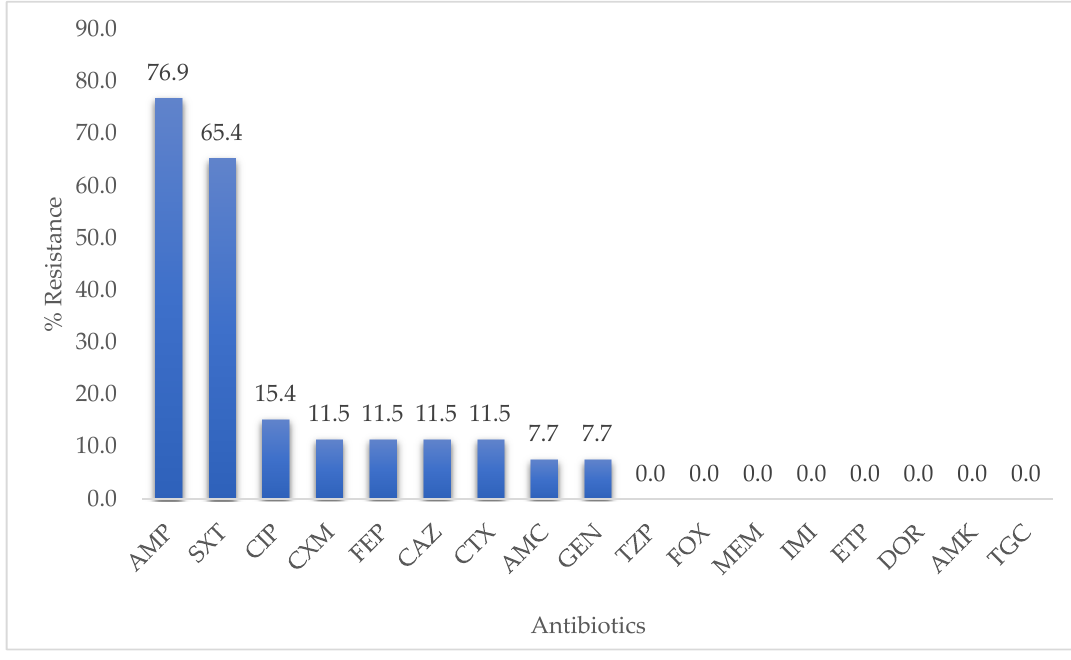
Figure 1. Overall percentage resistance to tested antibiotics. AMP = Ampicillin, SXT = Trimethoprim- sulfamethoxazole, CIP = Ciprofloxacin, CXM = Cefuroxime, FEP = Cefepime, CAZ = Ceftazidime, CTX = Cefotaxime, AMC = Amoxicillin/clavulanate, GEN = Gentamycin, TZP = Piperacillin- tazobactam, FOX = Cefoxitin, MEM = Meropenem, IMI = Imipenem, ETP = Ertapenem, DOR = Doripenem, AMK = Amikacin, TGC = Tigecycline.